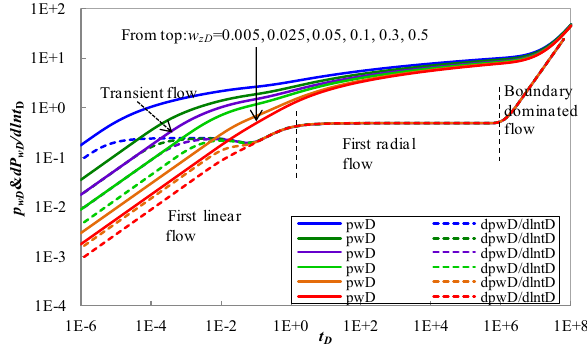
Fig. 5 The flow division schematic of partial penetration fractured vertical